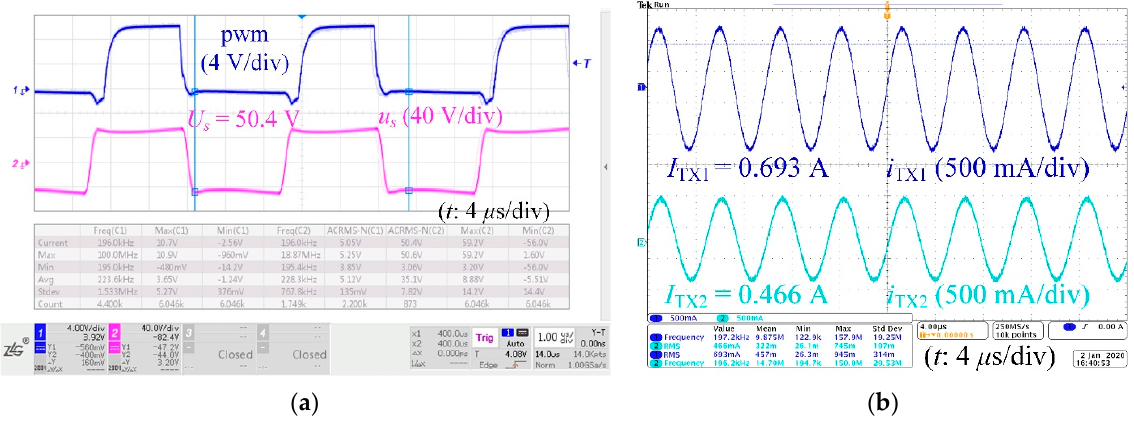
Figure 14. As h = 37 cm, m = n = 4, ( a ) the input voltage Us ; ( b ) the currents in the TX1 and TX2.